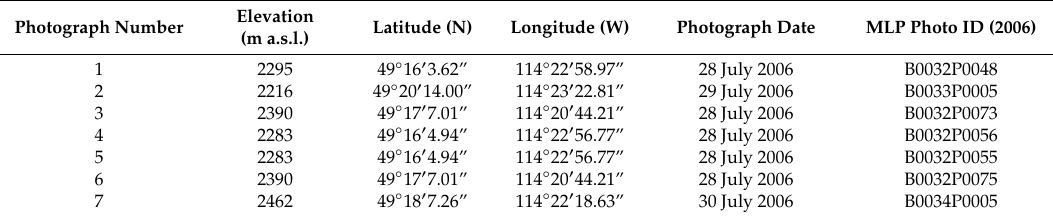
Figure 1. Seven repeat photograph pairs of WCW; the black and white series by M.P. Bridgeland, 1914, courtesy of Library and Archives Canada; color series copyright 2006, Mountain Legacy Project. Photo 1; ( a ) 1914, ( b ) 2006, Photo 2; ( c ) 1914, ( d ) 2006, Photo 3; ( e ) 1914, ( f ) 2006, Photo 4; ( g ) 1914, ( h ) 2006, Photo 5; ( i ) 1914, ( j ) 2006, Photo 6; ( k ) 1914, ( l ) 2006, Photo 7; ( m ) 1914, ( n ) 2006. See Table 1 for further details. Table 1. Collection data for Mountain Legacy Project 2006 photographs. Information for the corresponding 1914 data can be found at www.mountainlegacy.ca.